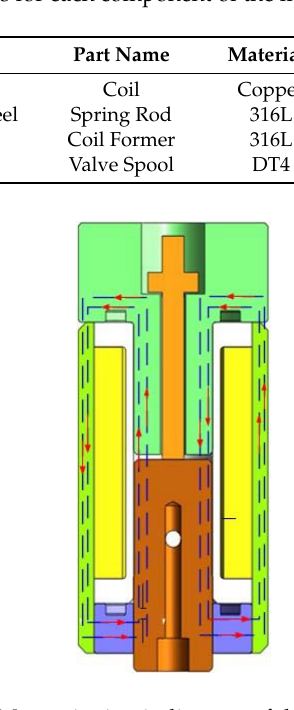
Figure 1. Structure diagram of the micro digital valve. Table 3. Materials for each component of the miniature digital valve.